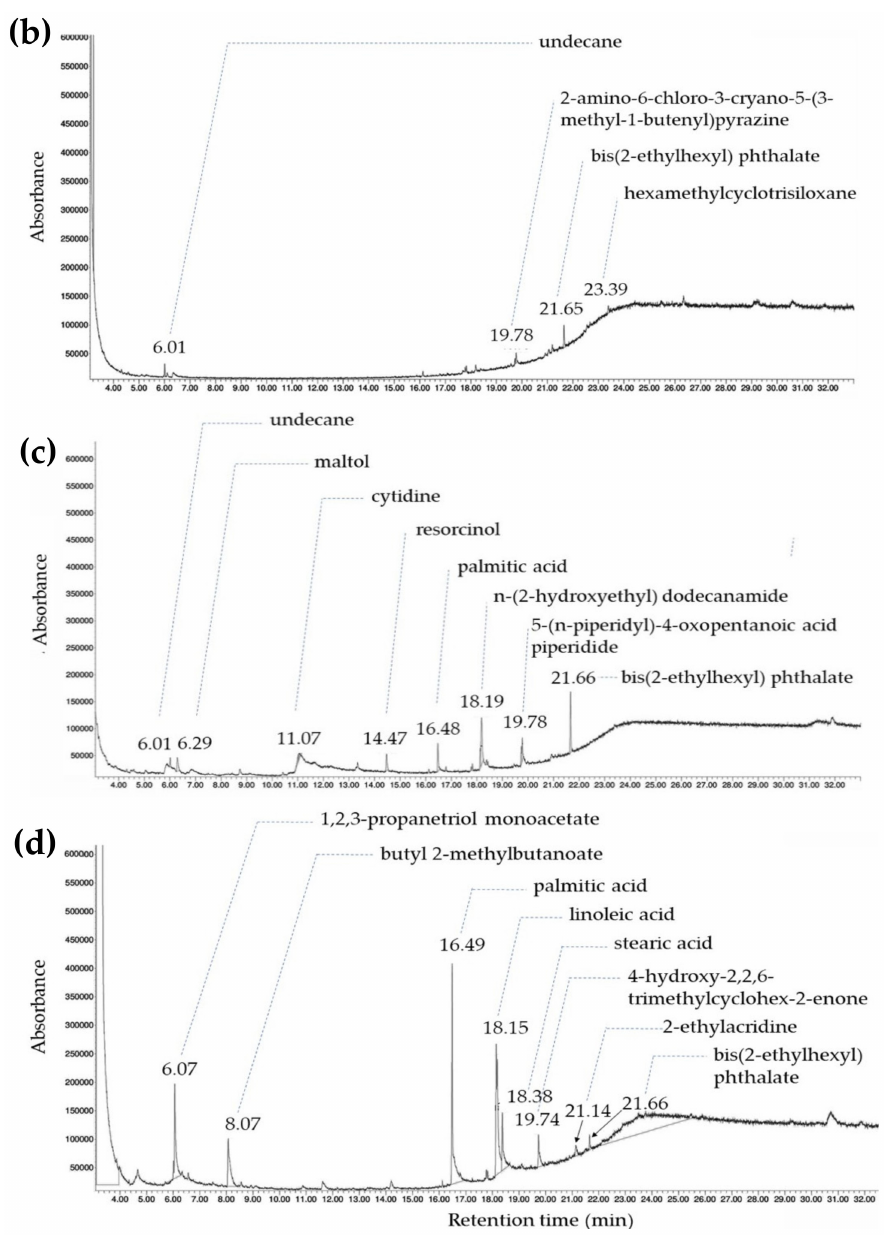
Figure 4. GC–MS chromatograms of ethanolic seed extracts belonged to four Mucuna species. ( a ) M . gigantea (MGG), ( b ) M. interrupta (MIT), ( c ) M. monosperma (MMM), ( d ) M. pruriens